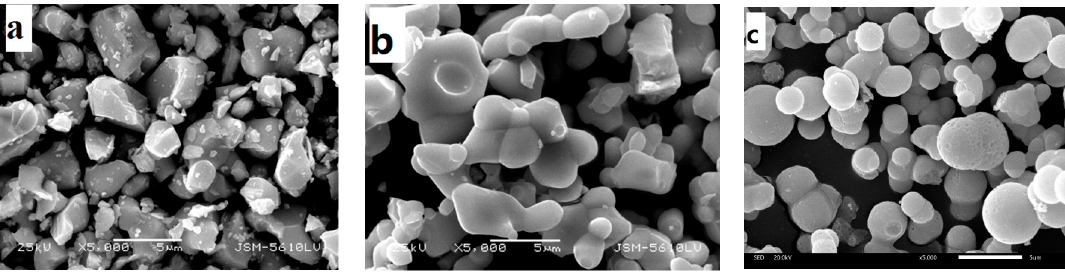
Figure 13. SEM image of ( a ) Y 2 O 3 :Eu sintered at 1100 ° C; ( b ) Y 2 O 3 :Eu sintered at 1100 ° C with sintering aids; and ( c ) the commercial red phosphor.